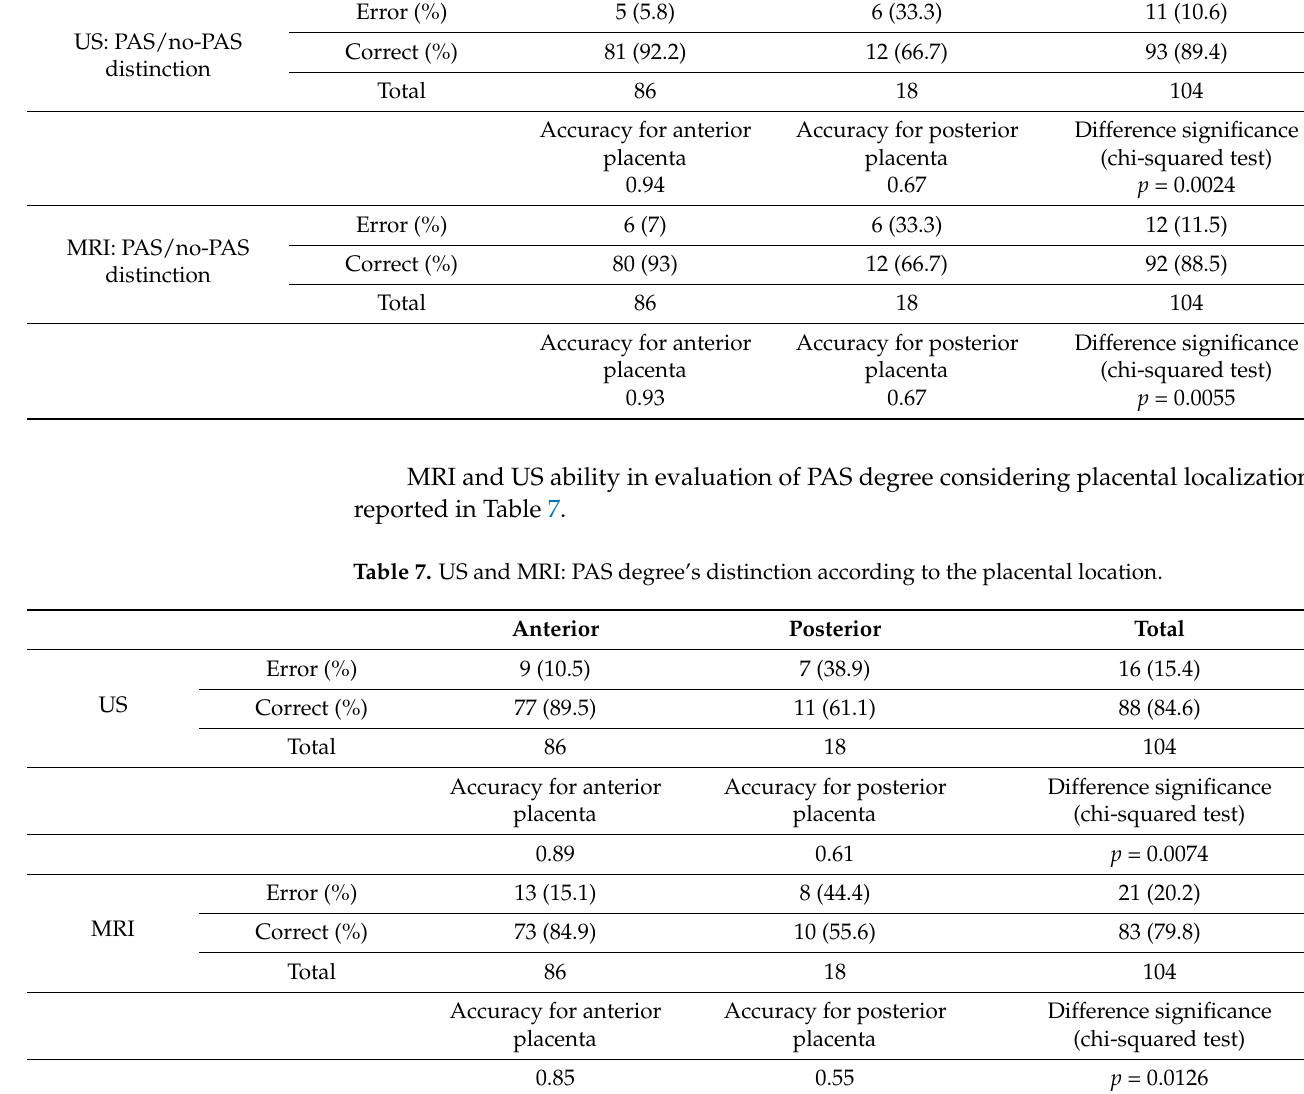
Table 6. US and MRI: PAS/no-PAS distinction according to placental location. Anterior Posterior Total